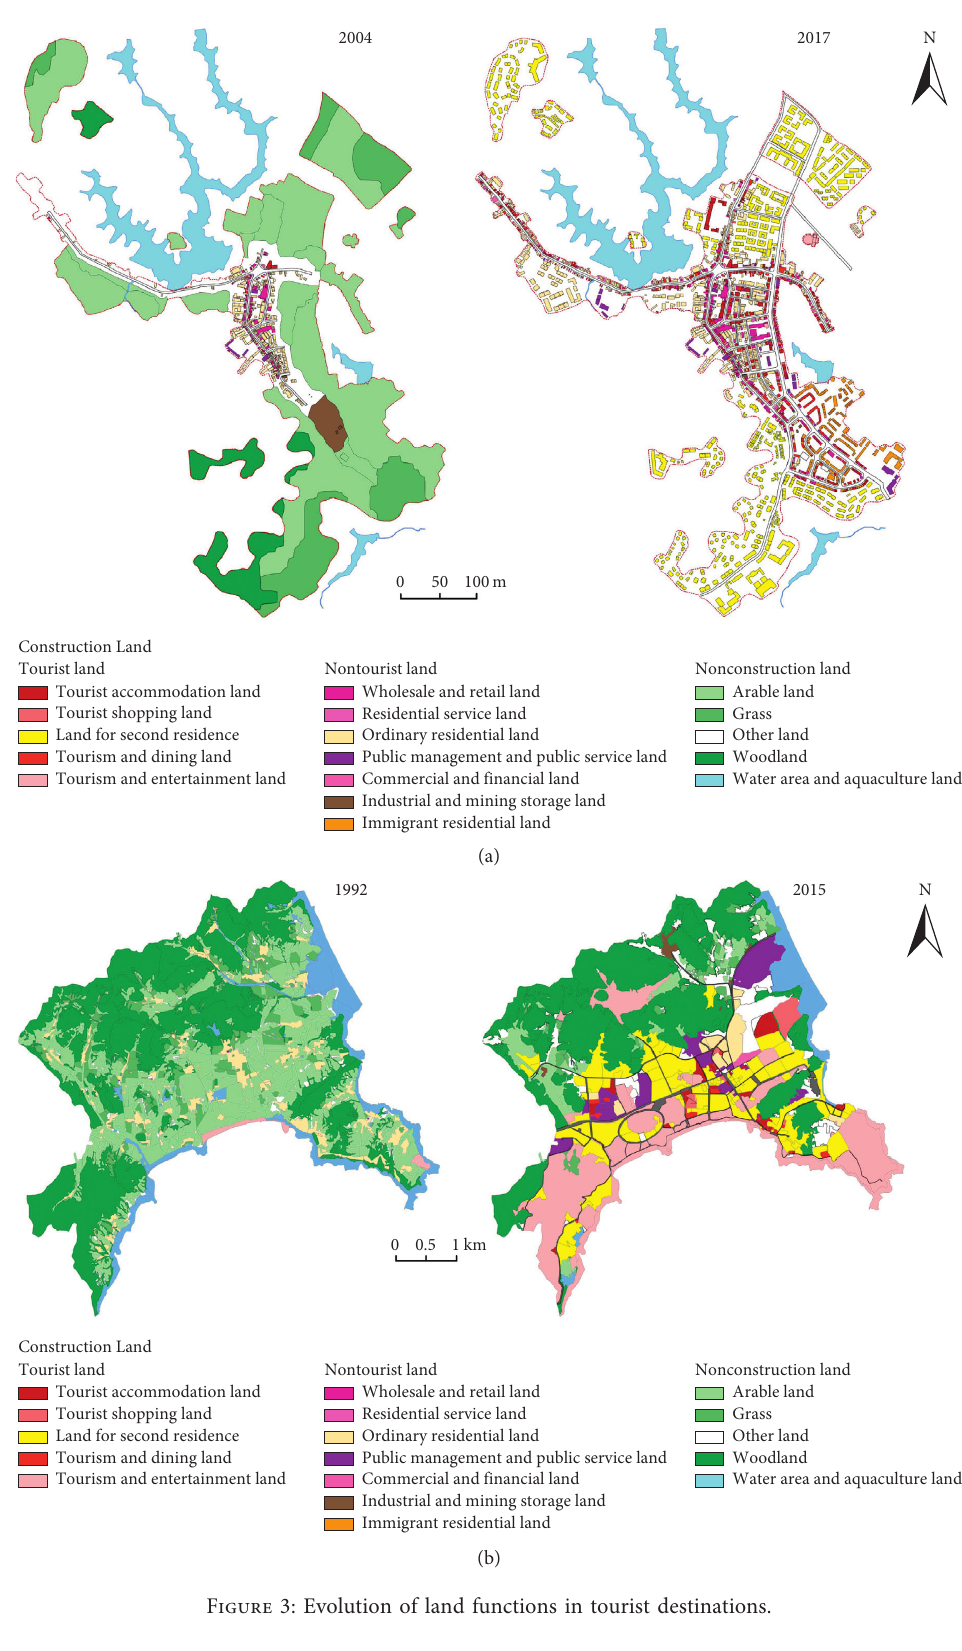
Figure 3: Evolution of land functions in tourist